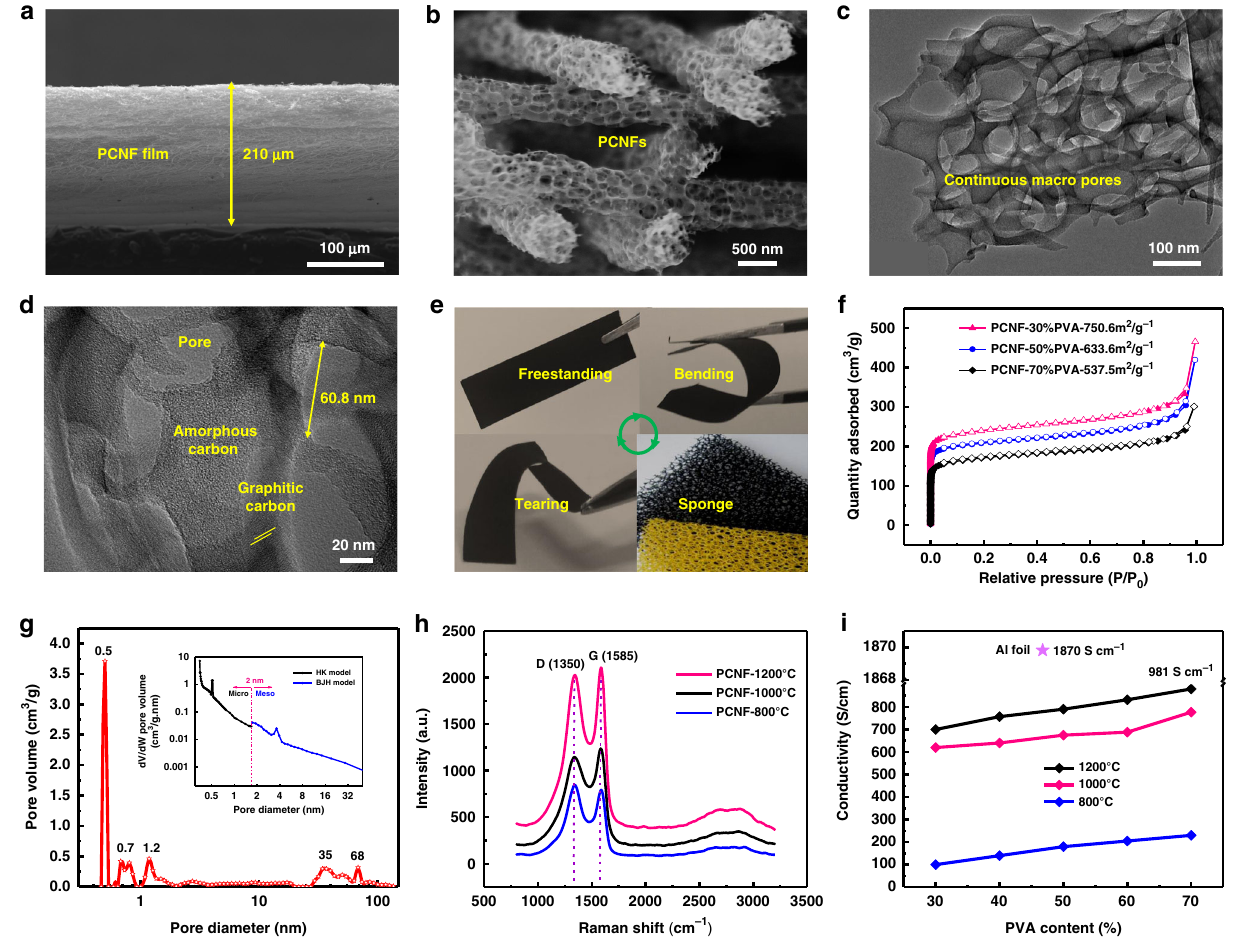
Fig. 2 Characterizations of PCNF fi lms. a A cross-sectional SEM image of the PCNF fi lm with a thickness of 210 µ m. b A high-magni fi cation SEM image of the PCNFs with continuous macropores. c , d TEM images of a single PCNF. e Demonstration of the robustness of the freestanding PCNF fi lms. f , g N 2 adsorption – desorption isotherms of PCNFs. h Raman spectra of PCNFs with different pyrolysis temperatures. i Conductivity of PCNFs that produced different pyrolysis temperatures and PVA contents. Source data are provided as a Source Data fi